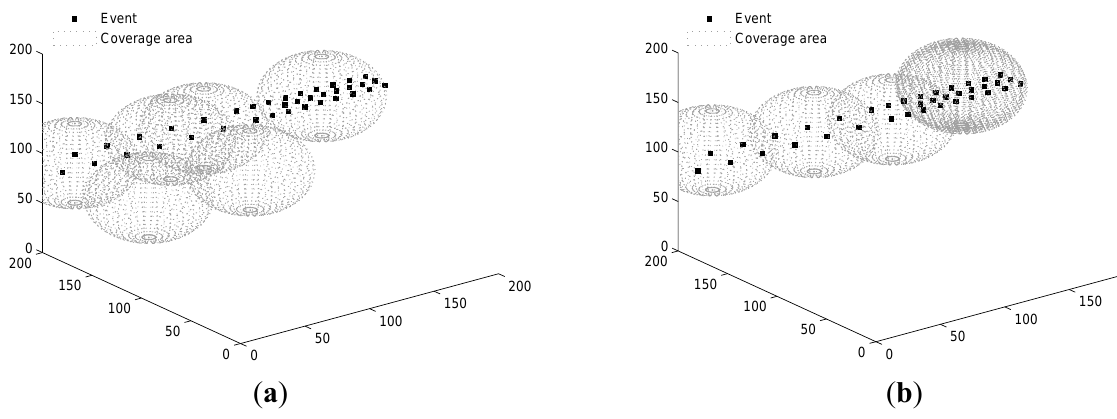
Figure 7. The evolving of ( ) E η of the two algorithms in three sets of